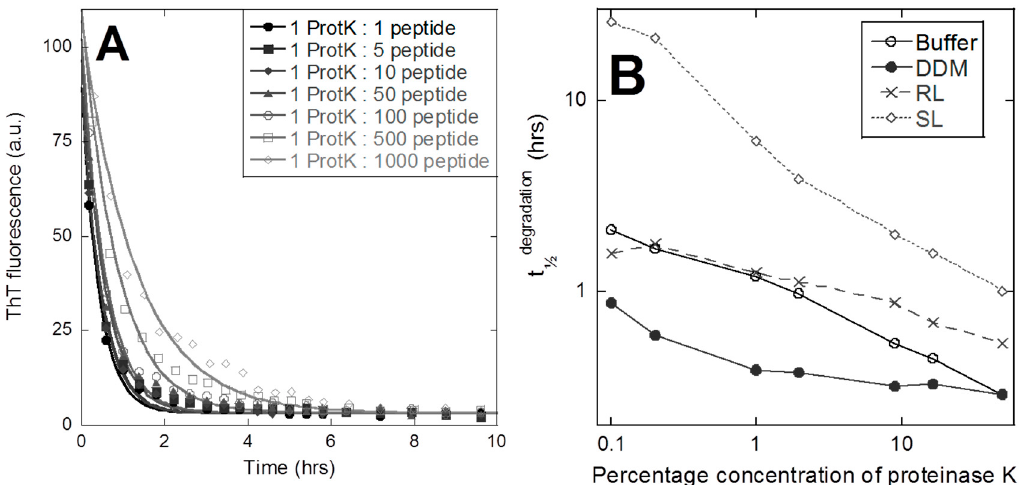
Figure 4. Proteolysis of 3474 aggregates correlates with levels of release. Degradation of 3474 aggregates by proteinase K. ( A ) ThT fluorescence over time of 3474-DDM aggregates incubated with different molar ratios (proteinase K-peptide) of proteinase. ( B ) The t½ values from ThT-fluorescence decays of the four different types of 3474 aggregates follow an approximately linear relationship in a log–log plot, when plotted versus the fraction of proteinase K.